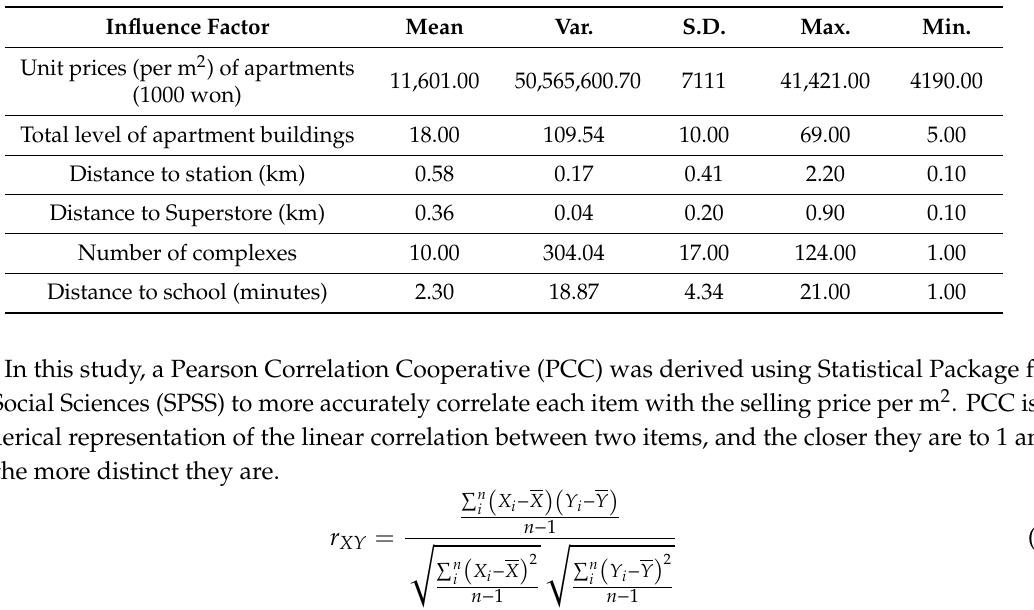
Table 2. The selling price (per m 2 ) and the descriptive statistical table for